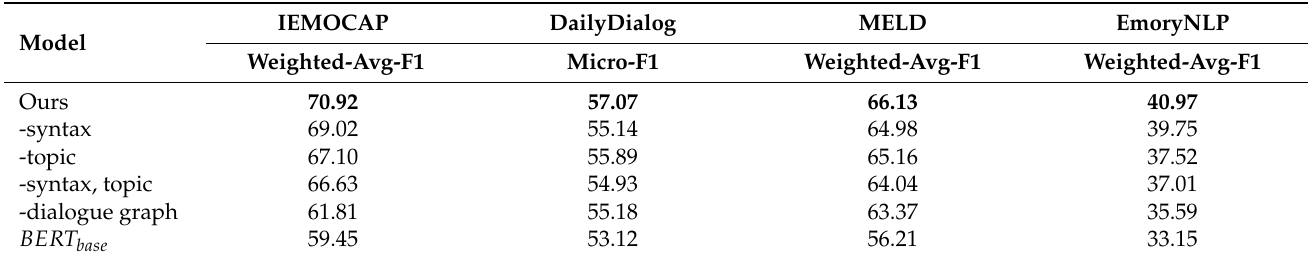
Table 4. Results of ablation study on four